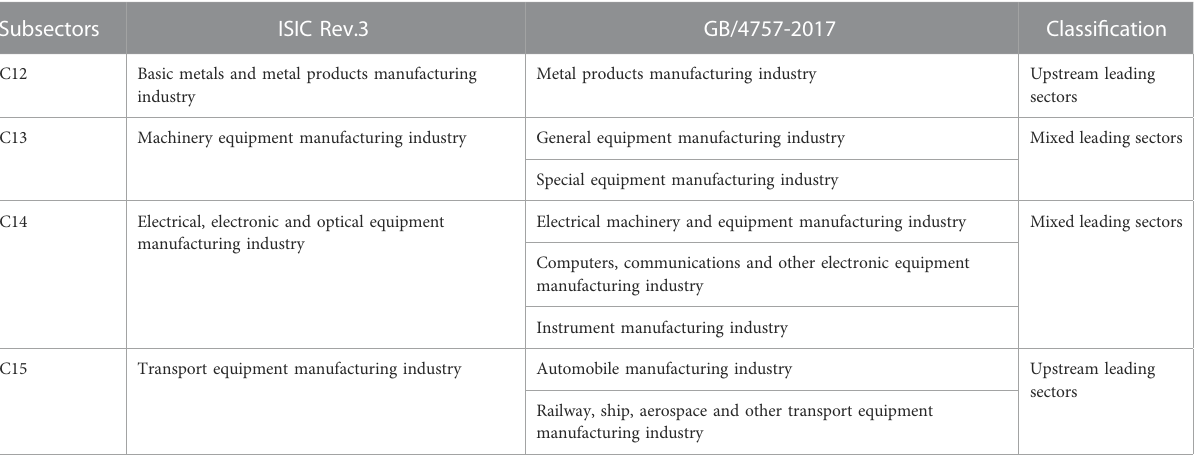
TABLE 2 Subsectors classi fi cation of equipment manufacturing